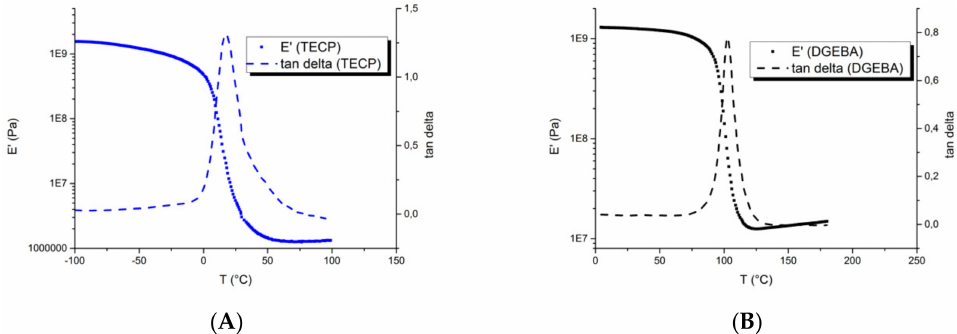
Figure 4. E (cid:48) ( A -left) and tan δ ( B -right) of DMA curves for eugenol-based materials (red: DEEP; green: TEEP; magenta: DEEP-Ph).